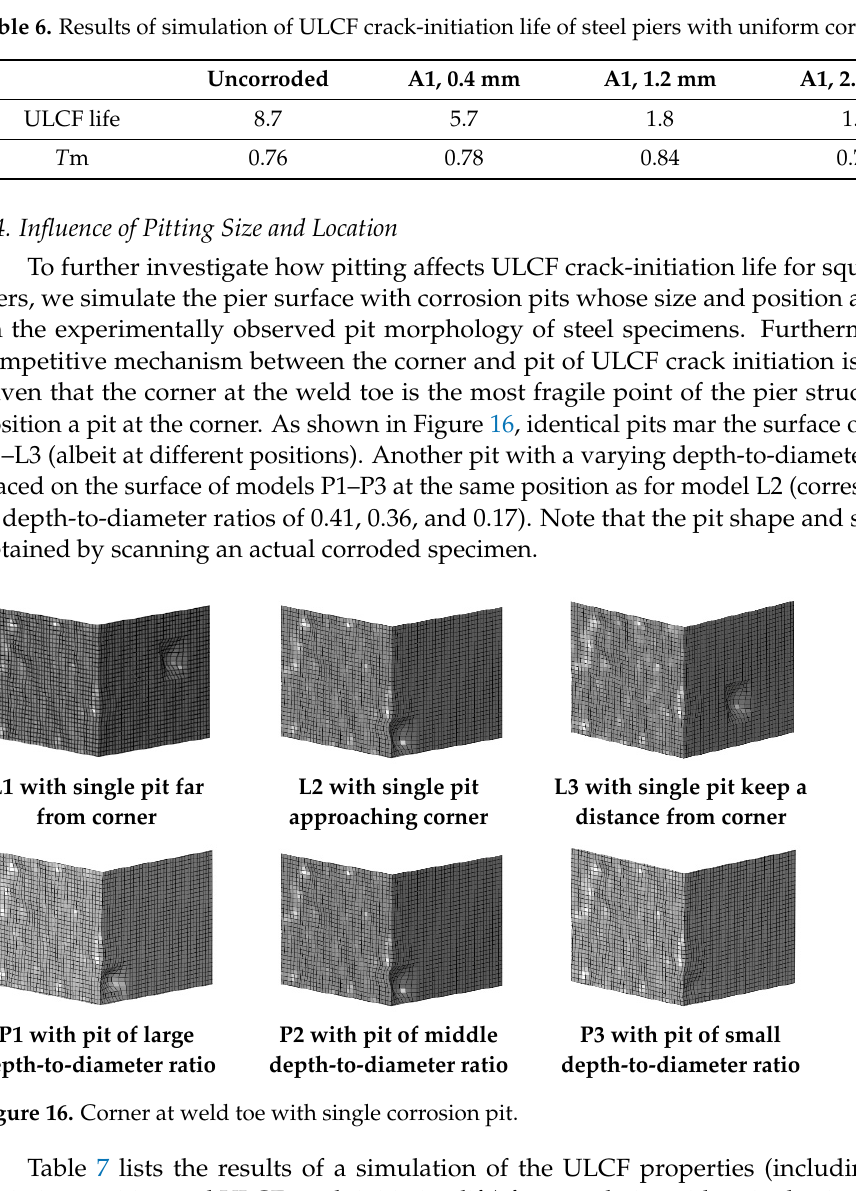
Table 7. Results of simulation of ULCF crack-initiation life for steel piers with corrosion pits in different positions and with different depth-to-diameter ratios.